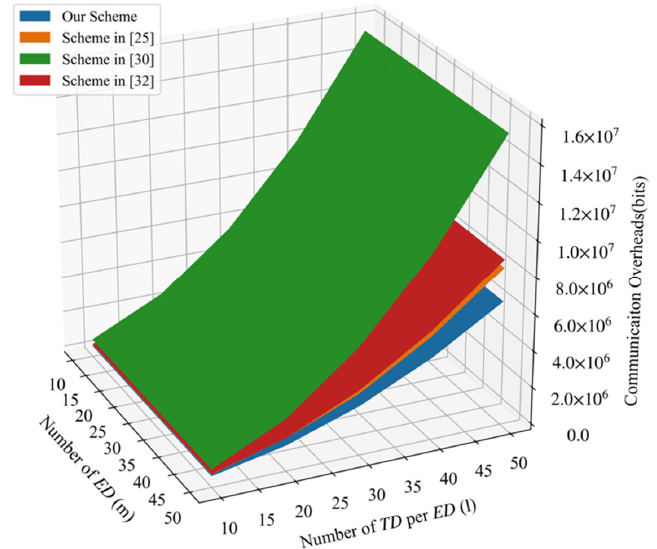
Figure 5. Comparison of communication overheads.